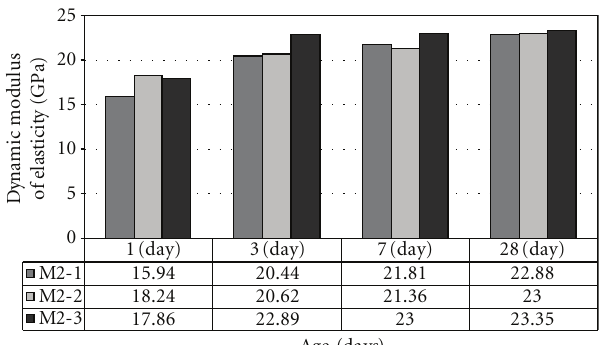
Figure 4: The dynamic modulus of elasticity for the 2nd group of specimens.